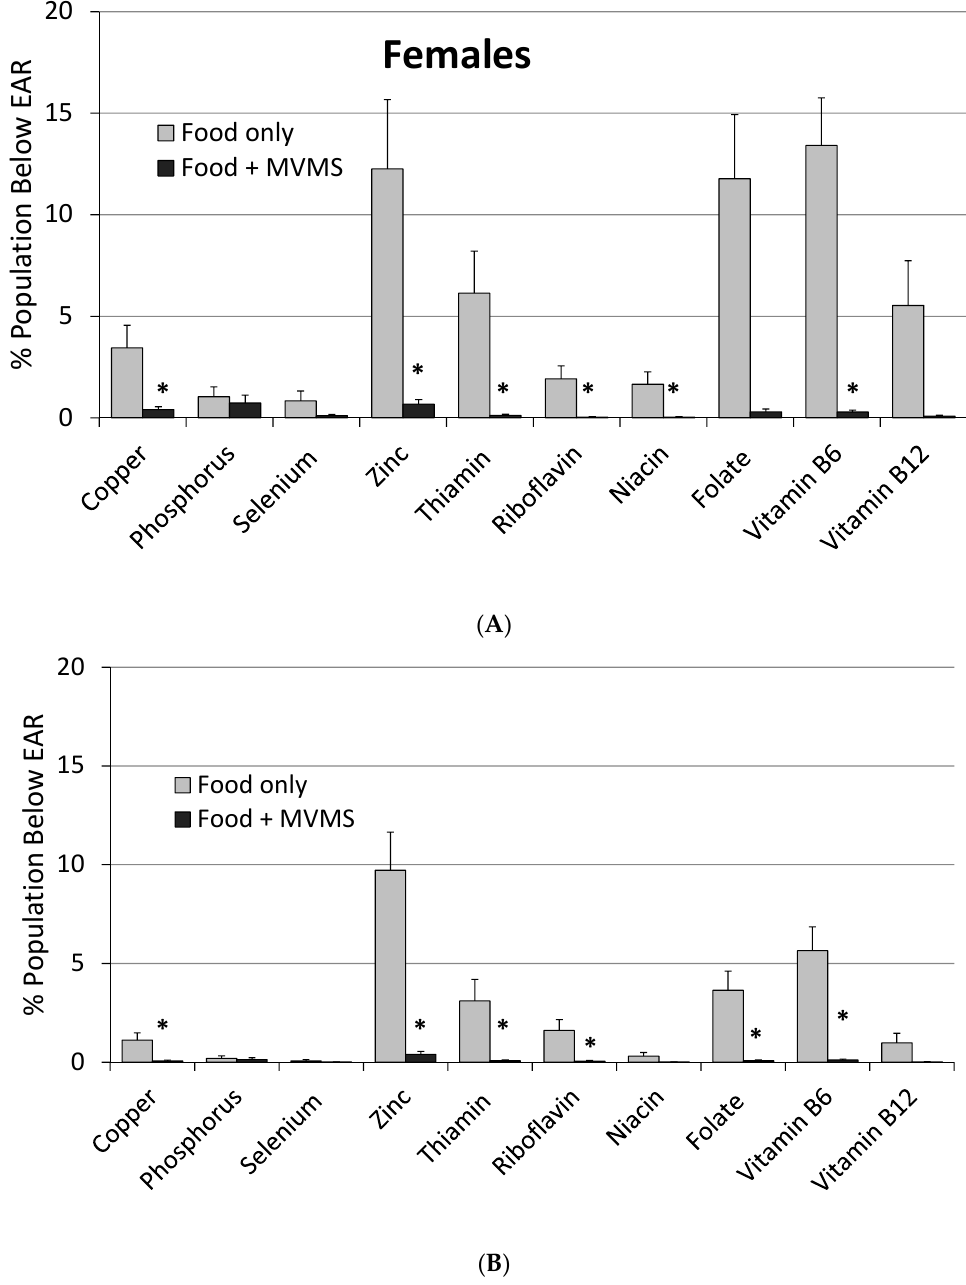
Figure 2. Prevalence of inadequacy (% of population below EAR) of intakes of other micronutrients from food only and food + MVMS among females and males age 19 years and older reporting taking a MVMS. NHANES 2009–2012. ( A ) Females; ( B ) Males. * Significantly different from Food only at p < 0.01. EAR: estimated average requirement; MVMS: multi-vitamin/multi-mineral supplements; NHANES: National Health and Nutrition Examination Survey.